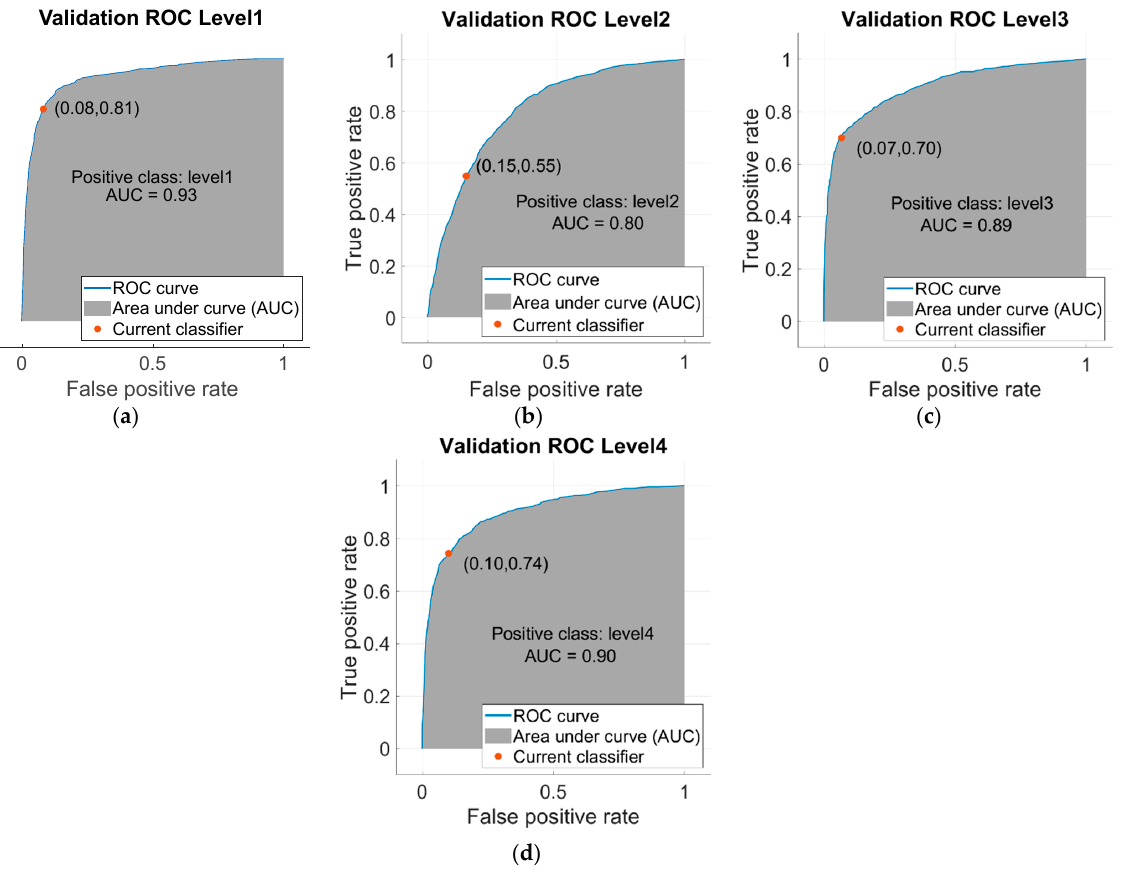
Figure A1 . ( a ) Validation curve of "X" axis level1; ( b ) Validation curve of “X” axis level2; ( c ) Valida- Figure A1. ( a ) Validation curve of “X” axis level1; ( b ) Validation curve of “X” axis level2; ( c ) Validation tion curve of “X” axis level3; ( d ) Validation curve of “X” axis level4. curve of “X” axis level3; ( d ) Validation curve of “X” axis